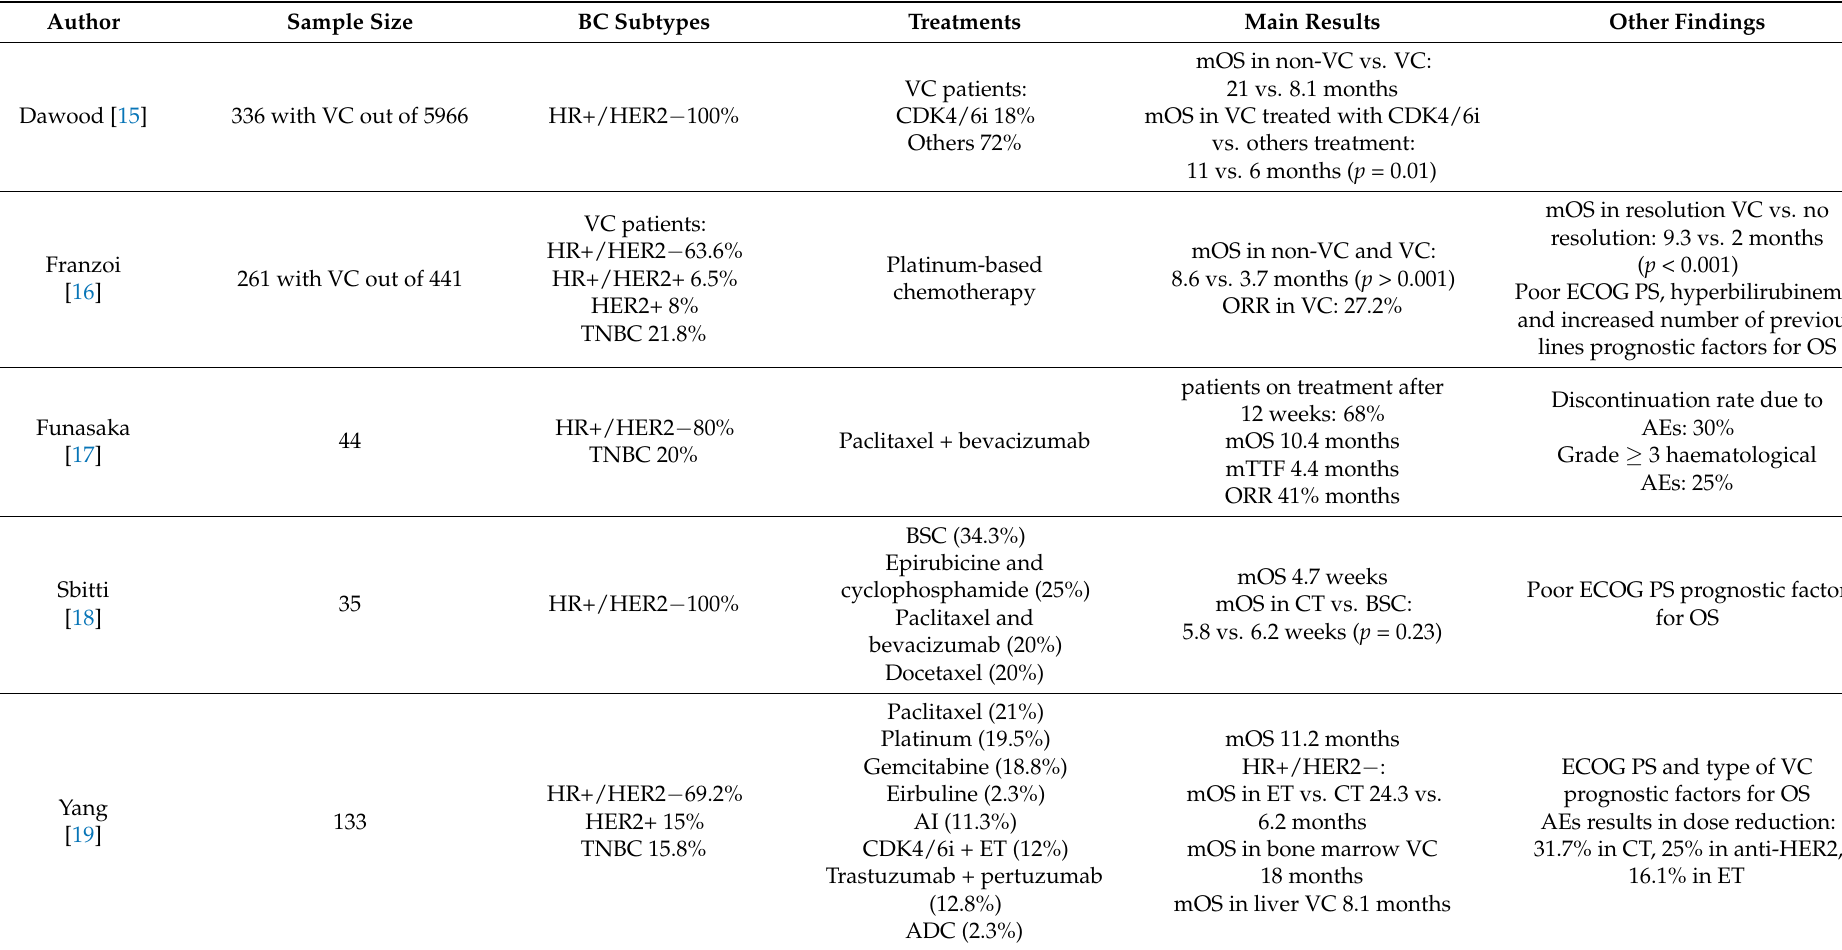
Table 1. Overview of the retrospective series of BC visceral